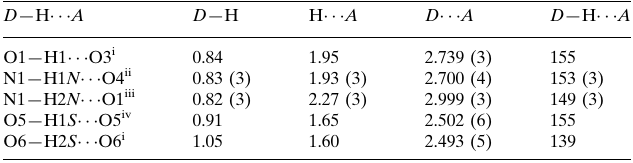
Data collection: CrysAlis CCD (Oxford Diffraction, 2007); cell refinement: CrysAlis CCD ; data reduction: CrysAlis RED (Oxford Diffraction, 2007); program(s) used to solve structure: SHELXS97 (Sheldrick, 2008); program(s) used to refine structure: SHELXL97 (Sheldrick, 2008); molecular graphics: ORTEP-3 (Farrugia, 1997); software used to prepare material for publication: SHELXL97